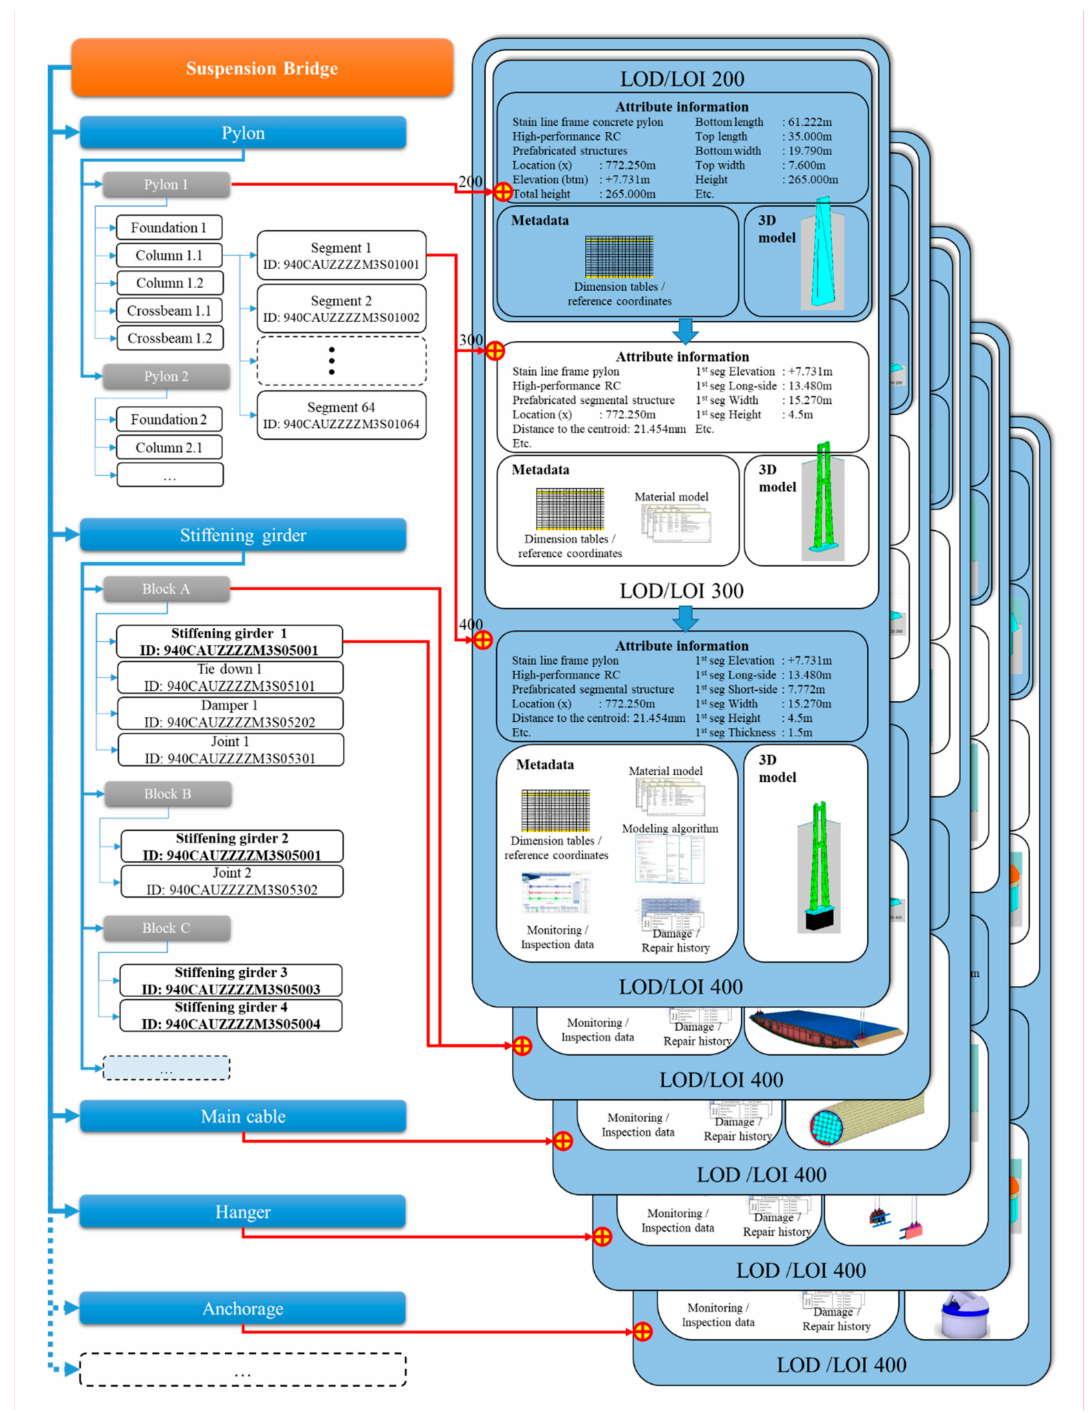
Figure 5. Example of the data schema of a suspension